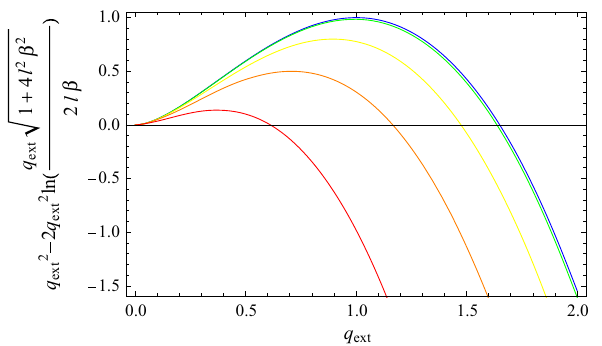
Fig. 4 The behaviors of the left-hand side of Eq. (19) versus q for β = 0 . 2, 0 . 5, 1, 4, and infinity, respectively, from below to the up lines, where we take l = 1